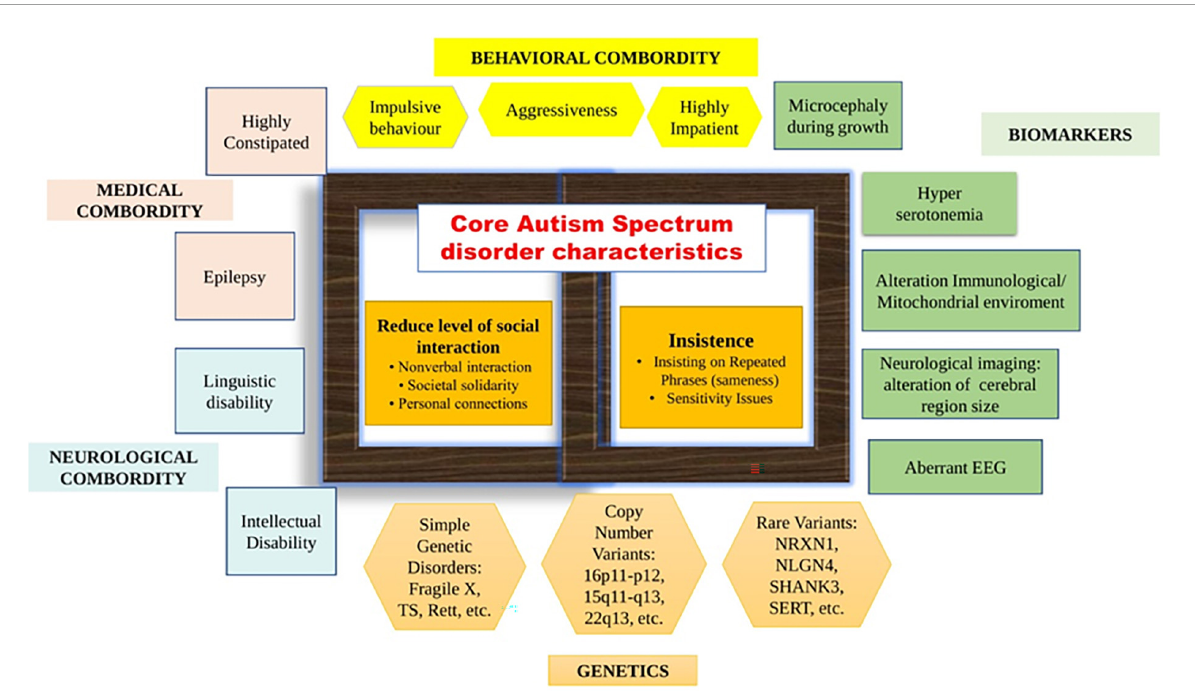
FIGURE1 Autism spectrum disorder (ASD) characteristics, complications, and biomarkers. In the middle of the figure, the key characteristics of ASD are depicted, as well as the typical traits necessary for a diagnosis. As per the Diagnostic and Statistical Manual of Mental Disorders-V (DSM-V) draught standards, all three social connectivity/interactions symptoms must be present to earn a diagnosis. One sector shows the deficiency of proper socialization and networking, which is one of the “negative characteristics” of ASD. In the DSM-V draught criteria, restricted/recurrent behavior signs are necessary for a diagnosis. Another sector indicates the occurrence of unusual limited, repetitive, or sensory activities, which are considered “positive signs” of ASD. Symptoms or biomarkers that are not necessary for an ASD diagnosis but are more frequent in ASD than in the regular populace can be found throughout the perimeter of the picture. A large range of complicated disorders or signs, including neurological, behavioral/psychiatric, and medical areas, are observed in a significant minority or perhaps a majority of people with ASD. Biomarkers and genetic data demonstrate high variation among individuals with ASD, as predicted given the wide range of comorbidity